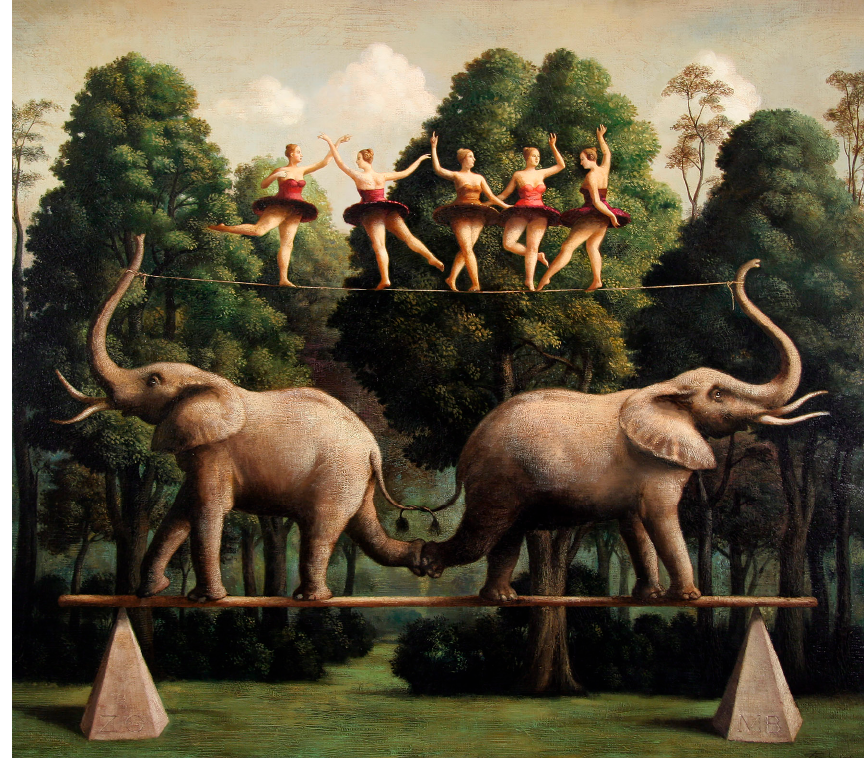
Figure 2. “Art of Balance” (2006). Painting by Ilya Zomb (http://www.zombart.com). The image displays both metaphorical and performed balance.